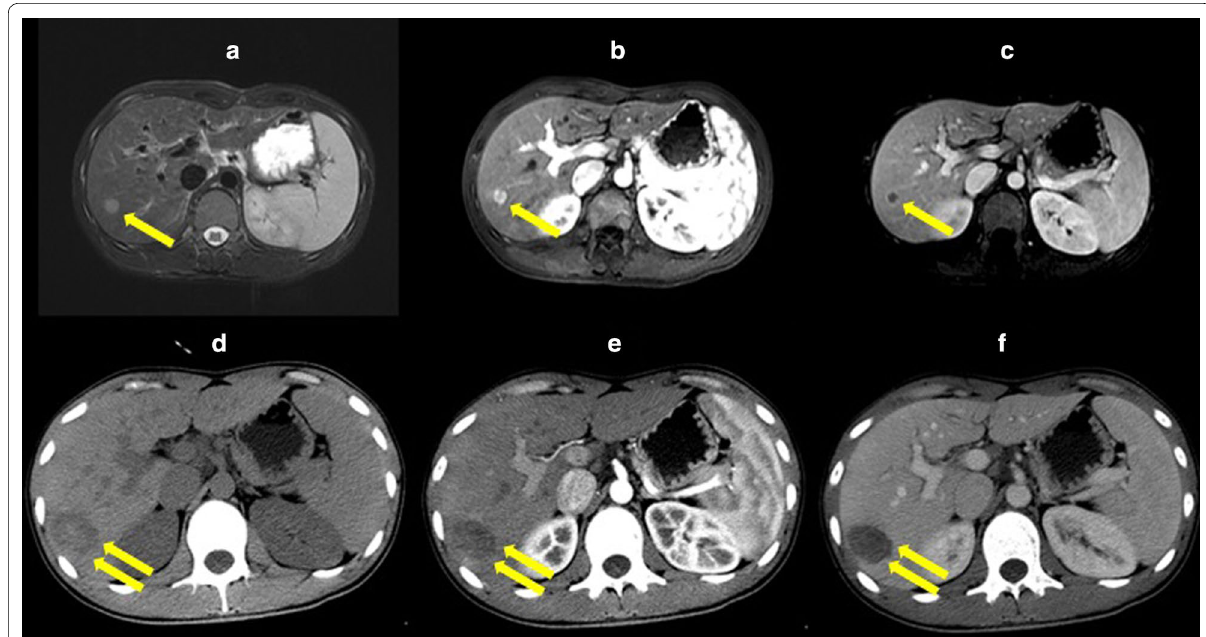
Fig. 1 Comparison of pre‑treatment and post‑treatment tumor lesion images of a 46‑year‑old patient with hepatocellular carcinoma (HCC) and hepatitis B‑related liver cirrhosis who underwent microwave ablation. Magnetic resonance images show a tumor with a small (15‑mm) hyper‑ intense nodule ( a T2‑weighted phase), intense arterial enhancement ( b arterial phase), and enhancement recession ( c portalvenous phase). Computed tomography images ( d noncontrast‑enhanced phase; e arterial phase; f portalvenous phase) obtained 2 days after treatment show no contrast enhancement inside or around the ablation